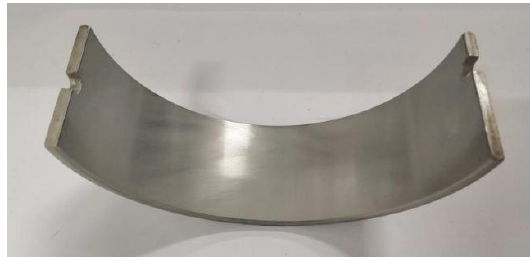
Figure 5. Bearing bush.